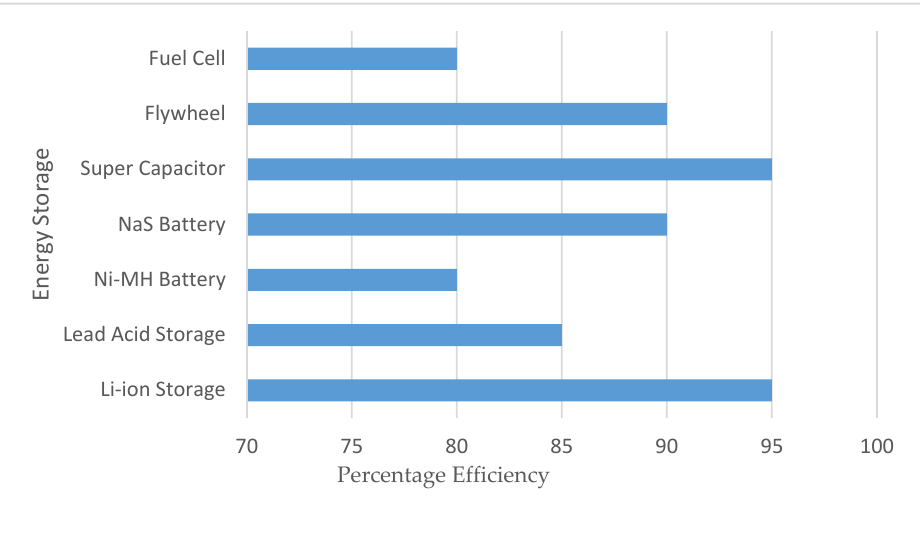
Figure 7. Energy efficiencies of different types of storage systems.